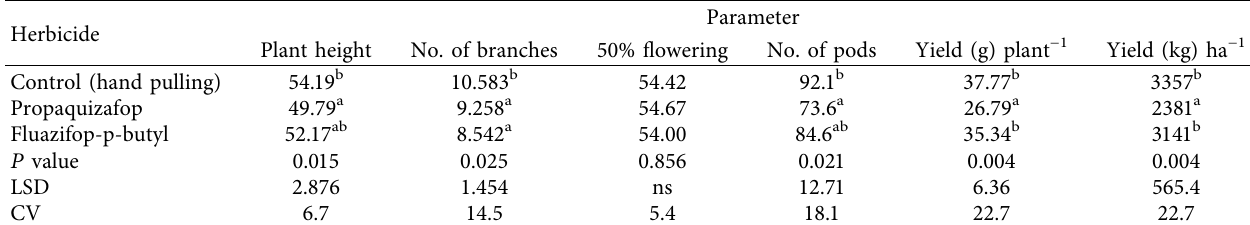
Table 2: Response of different sesame varieties to commonly used selective postemergence graminicides.